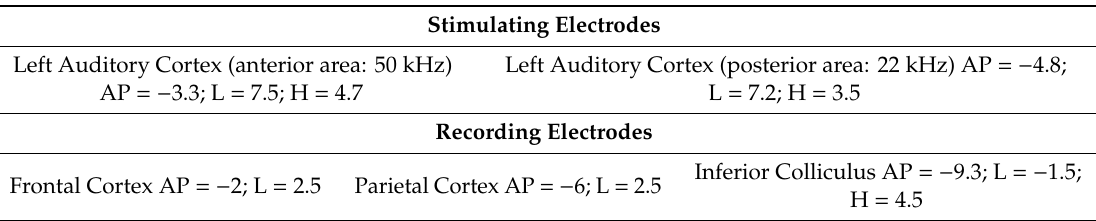
Table 1. Coordinates for recording and stimulating Electrode